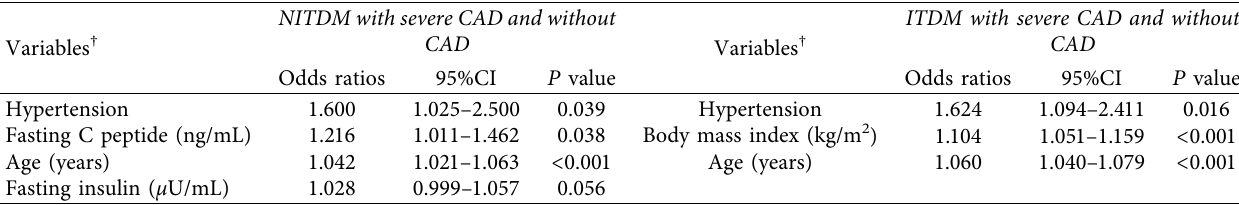
Table 2: Binary logistic regression coefficients for association between NITDM or ITDM with severe CAD and without CAD. Variables